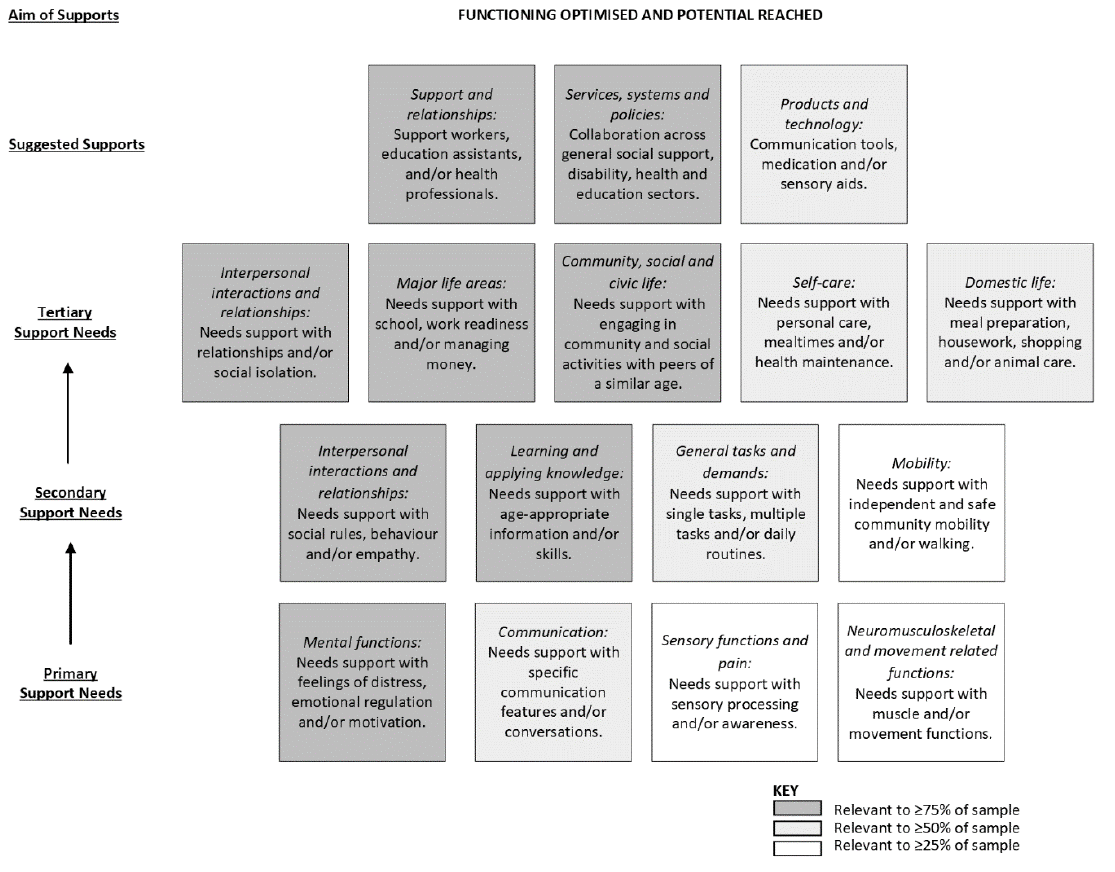
Figure 2. Hierarchical outcome space for young people, illustrating three interacting levels of support needs (primary to tertiary) that can be addressed through a combination of three types of suggested supports to achieve the overall aim for the young person.